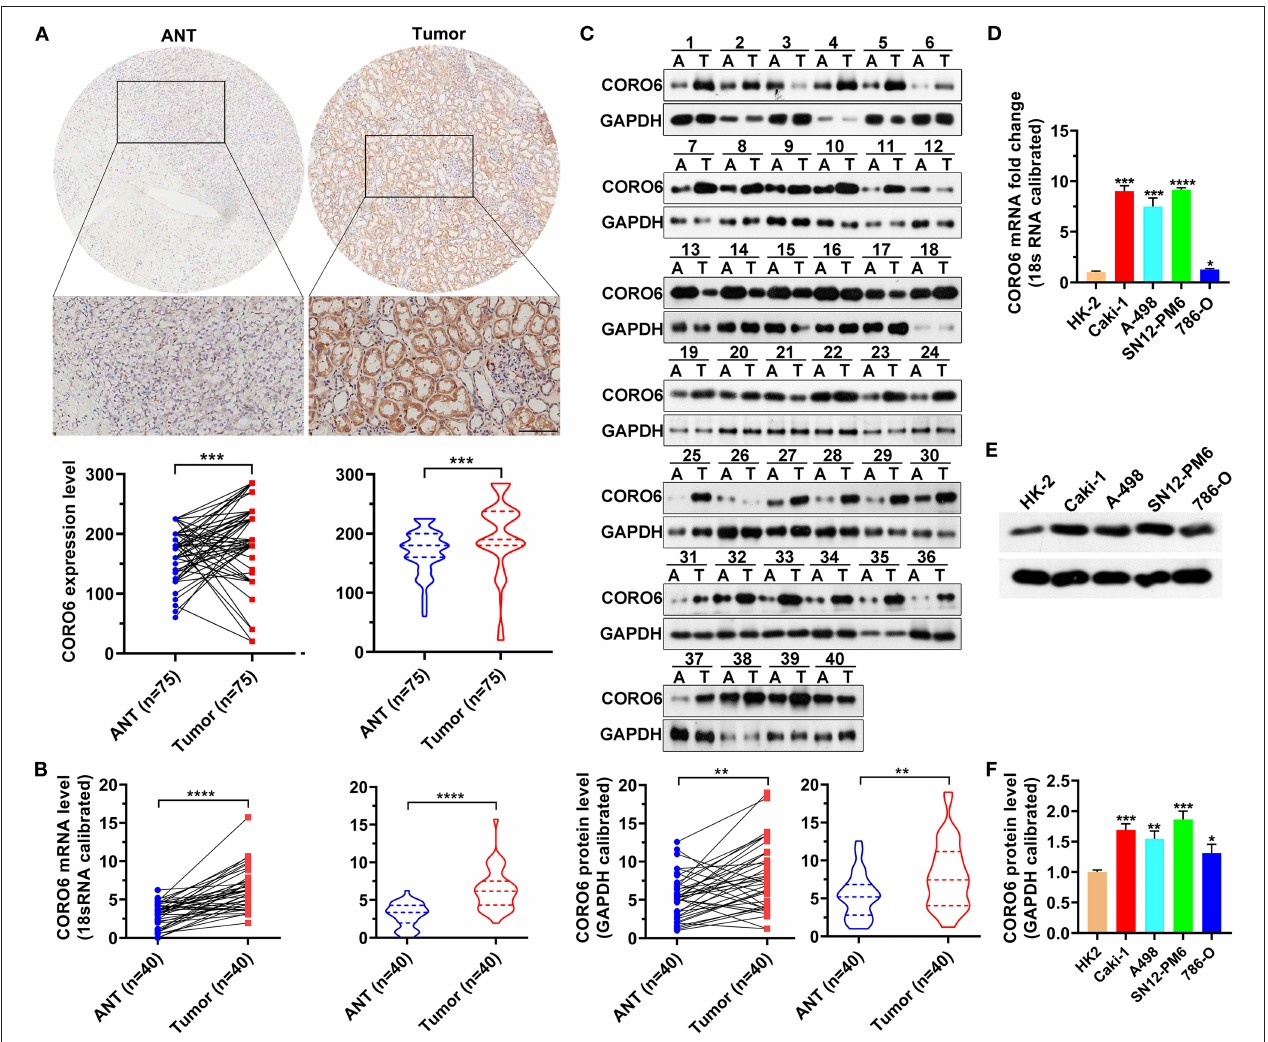
FIGURE 4 | Experimental validation of CORO6 expression in ccRCC samples and RCC cell lines. (A) IHC staining showed that CORO6 was overexpressed in ccRCC tumors. Top, representative images of CORO6 IHC staining in tissue microarrays. Bottom, quantification of CORO6 IHC staining in tissue microarrays with ccRCC tumors ( n = 75) and adjacent normal kidney tissues ( n = 75). (B) The CORO6 mRNA level was considerably increased in our collected ccRCC samples ( n = 40) compared to paired normal tissues ( n = 40). 18s rRNA served as the normalizing control. (C) The CORO6 protein level was significantly increased in our collected ccRCC samples ( n = 40) compared to paired normal tissues ( n = 40). (C) Western blotting showed that ccRCC tumors expressed a high level of CORO6. GAPDH served as the internal control. (D) The qPCR assay exhibited that RCC cell lines had a higher level of CORO6 compared to normal HK2 cells. Gene expression was normalized to 18s rRNA. (E) Western blotting confirmed that the CORO6 protein level was increased in RCC cell lines. GAPDH served as the loading control. (F) A quantification of (E) . * P < 0.05, ** P < 0.01, *** P < 0.001, and **** P < 0.0001. Ns, no